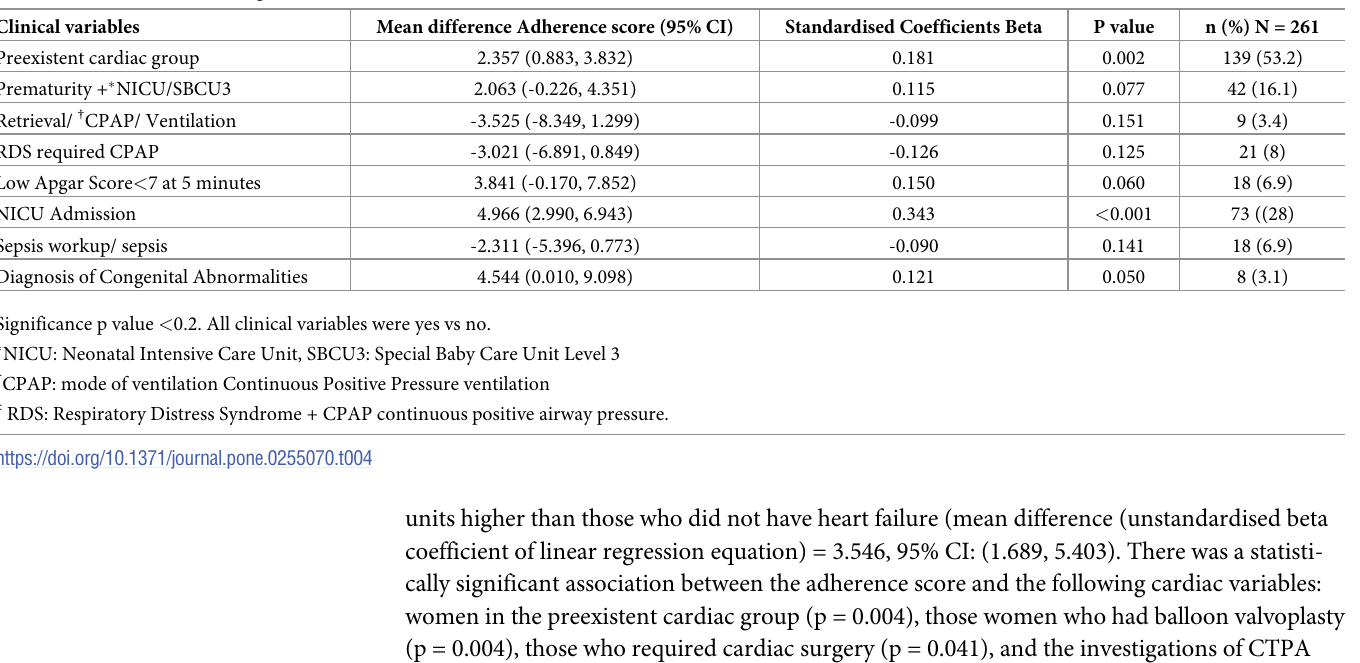
Table 4. Multivariable linear regression model results for the adherence score versus neonatal clinical